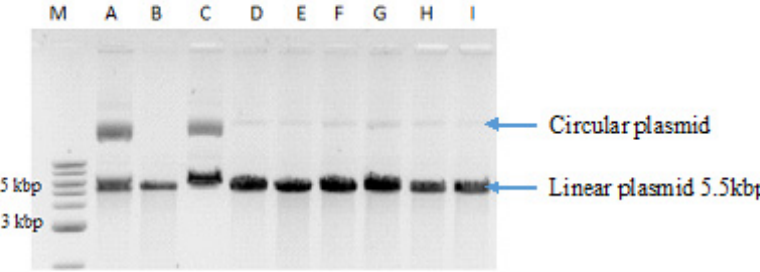
Figure 7. Digestion of pcDNA3.1HisC (total length 5.5 kbp) with BamH1 endonuclease. M - marker